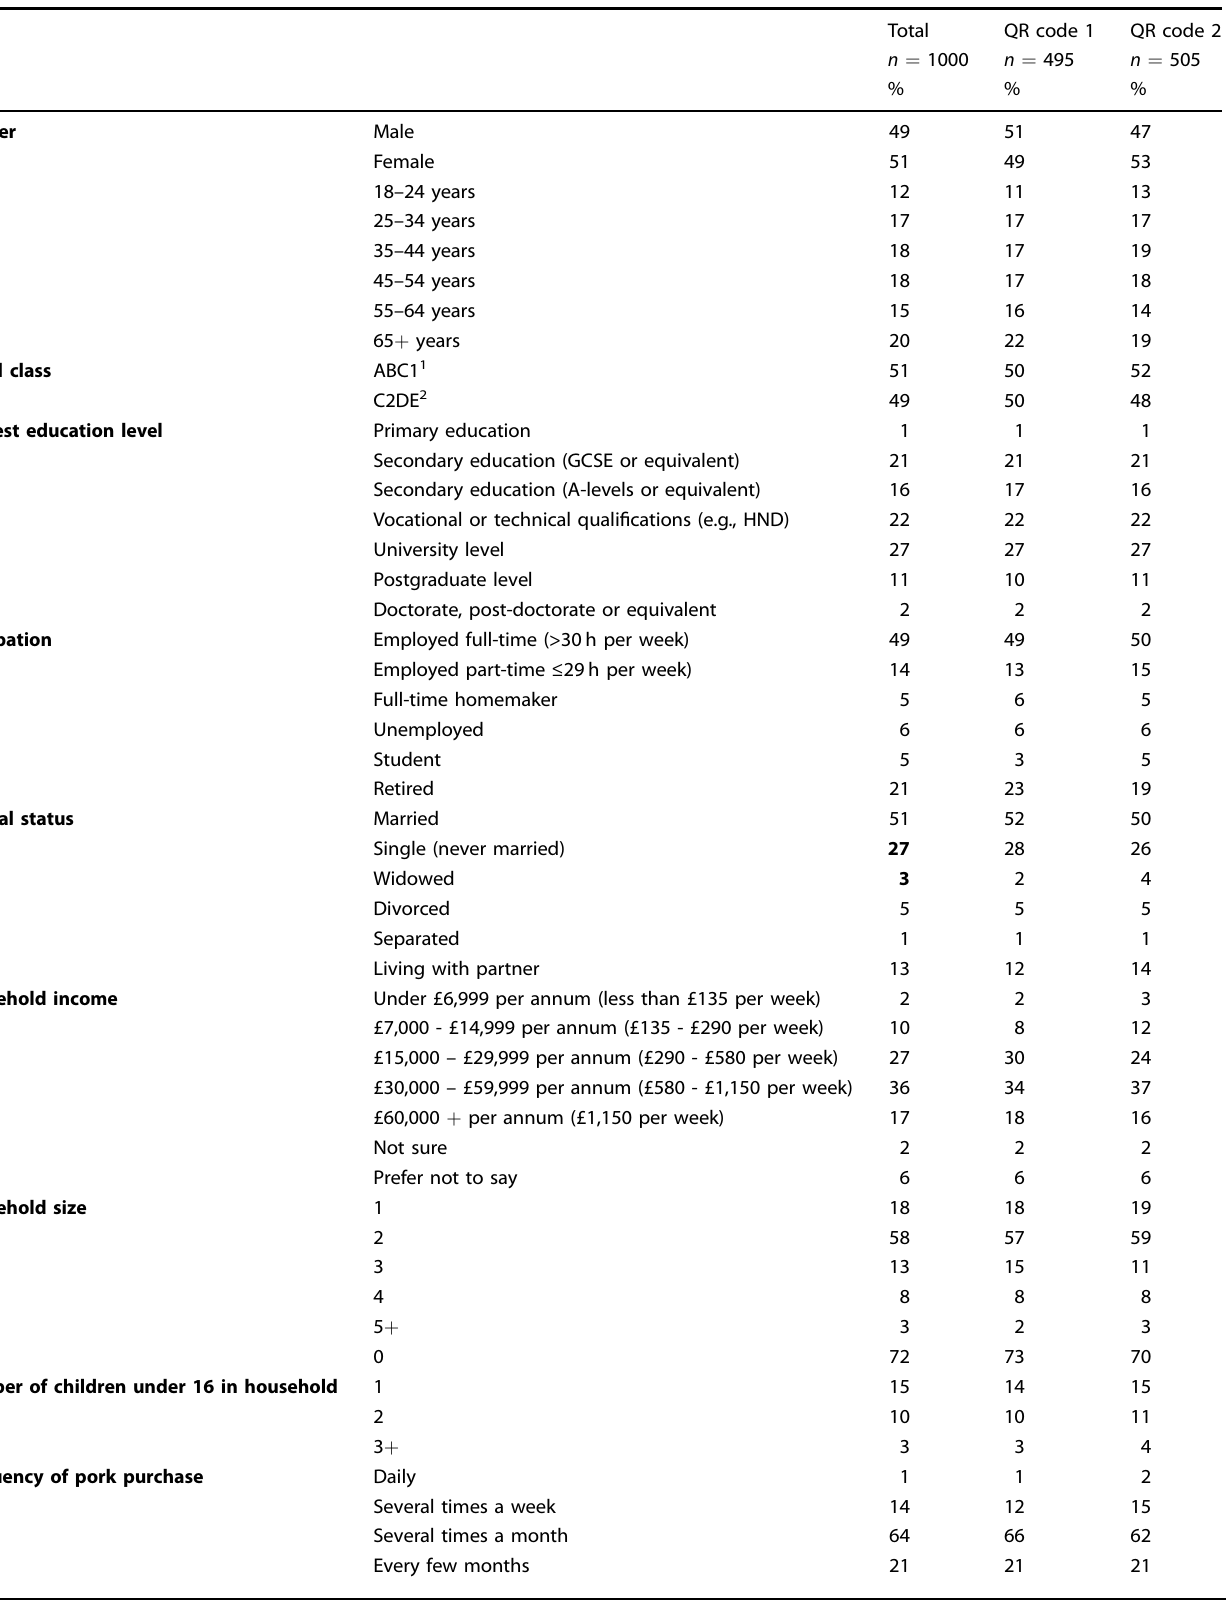
Table 1. Socio-demographic details and characteristics of the total study sample according to question completion related to QR code one or QR code